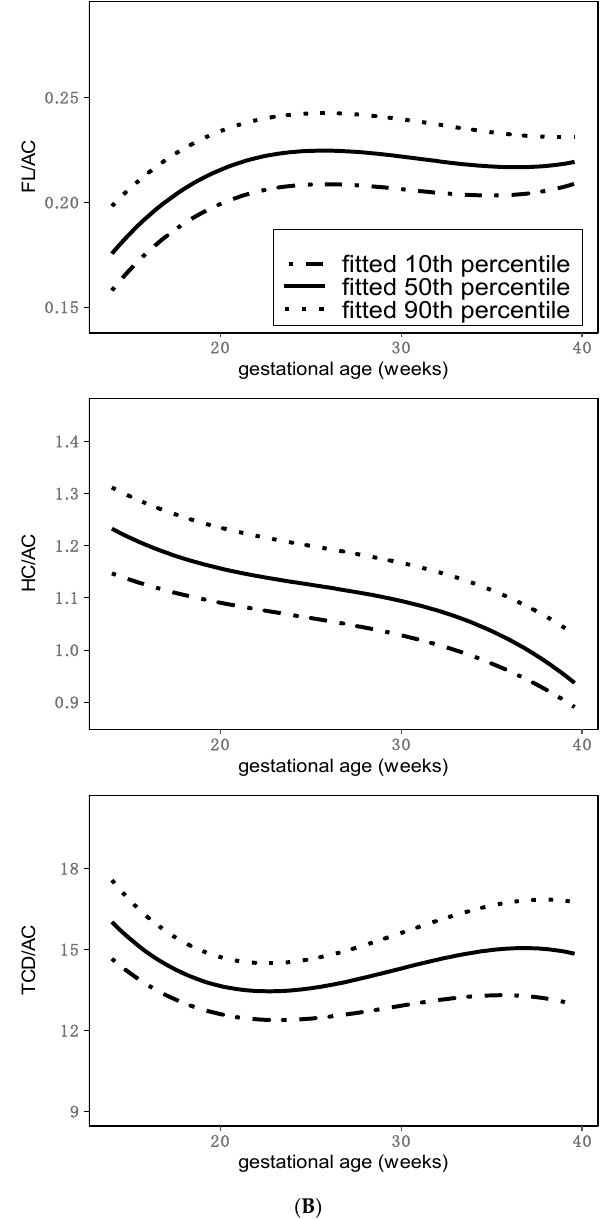
Figure 1. ( A ) Reference curves for the ultrasound parameters within this study population. Results of all quantile regression models are presented in Supplementary Table S1. AC = abdominal circumference, BPD = biparietal diameter, FL = femur length, HC = head circumference, TCD = transcerebellar diameter. ( B ) Reference curves for the ultrasound ratios within this study population. Results of all quantile regression models are presented in Supplementary Table S1. FL/AC = femur length/abdominal circumference, HC/AC = head circumference/abdominal circumference, TCD/AC = transcerebellar circumference/abdominal circumference.